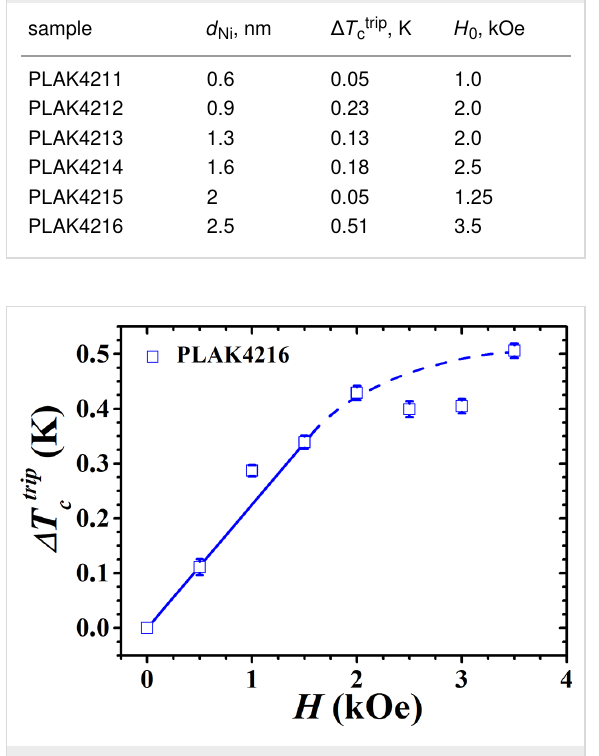
Figure 4: The magnitude of the triplet SSV as a function of the applied magnetic field for sample PLAK4216. The line is a guide to the eyes.